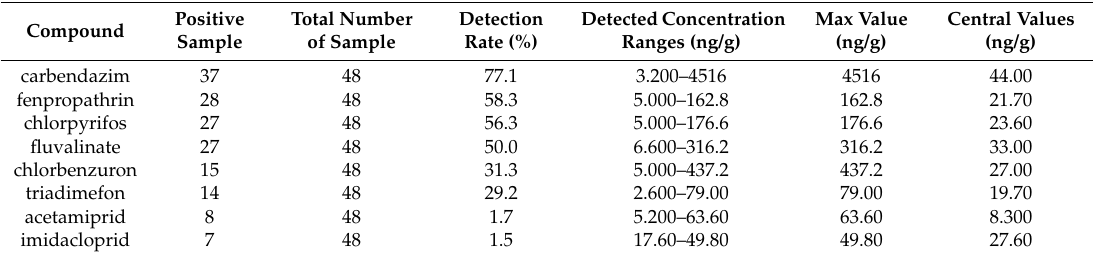
Table 5. Several typical pesticides in pollen